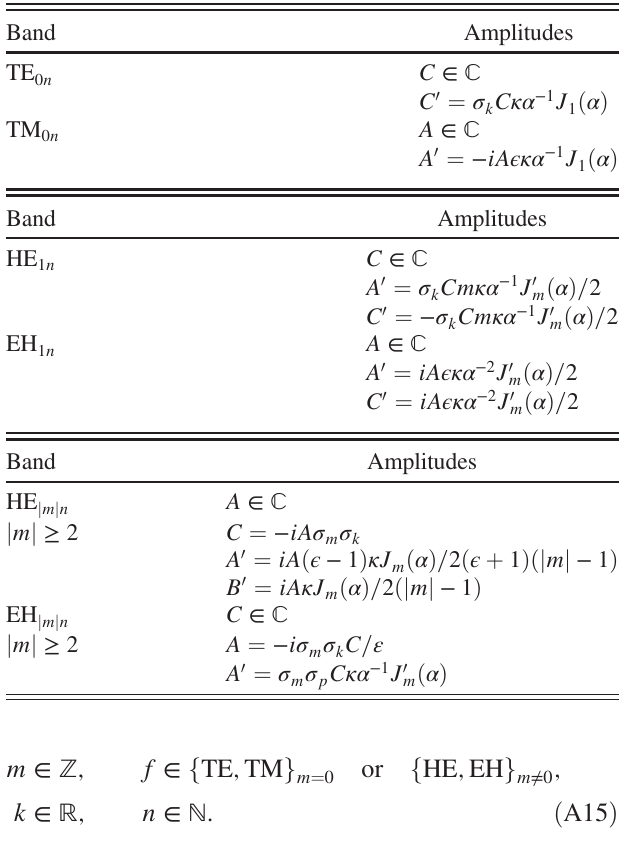
TABLE VIII. Weakly guided modes: The modal fields Eq. (A9) have radial partial waves given by case (1) in Table IV inside the fiber and by case (2) outside the fiber, with nonzero amplitudes listed in this table. Unprimed amplitudes apply inside the fiber, primed amplitudes outside the fiber. Amplitudes that are not listed vanish. All other quantities are defined in Table